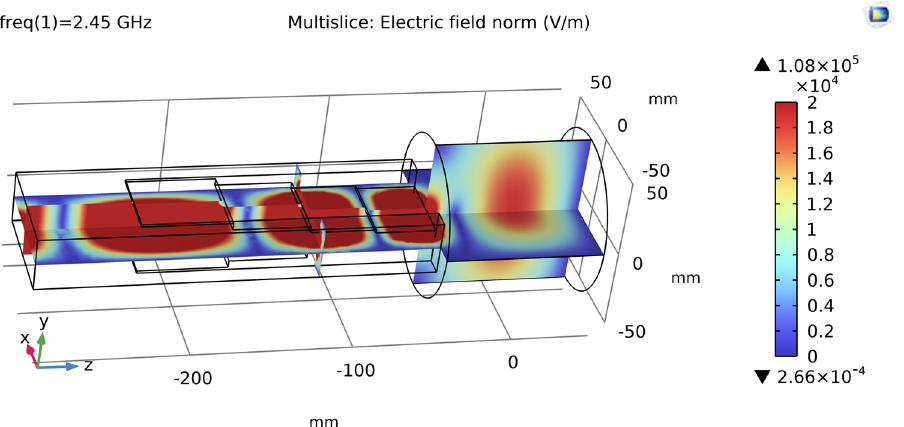
Figure 2. Microwave electric field amplitude (picture generated with